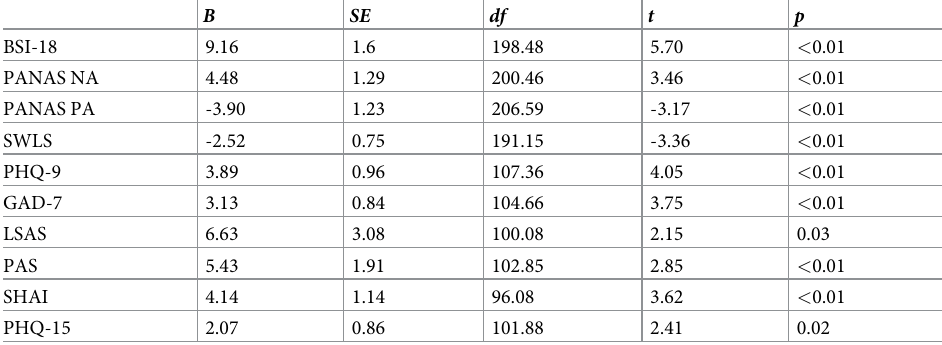
Table 3. Results from the linear mixed models for the interaction effect (time x group) for primary and secondary outcome measures (pre-post). B SE